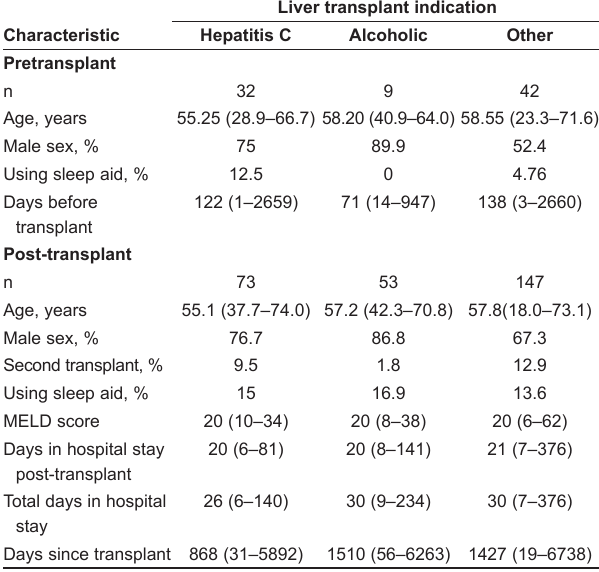
Table 1 Demographic characteristics of pre- and